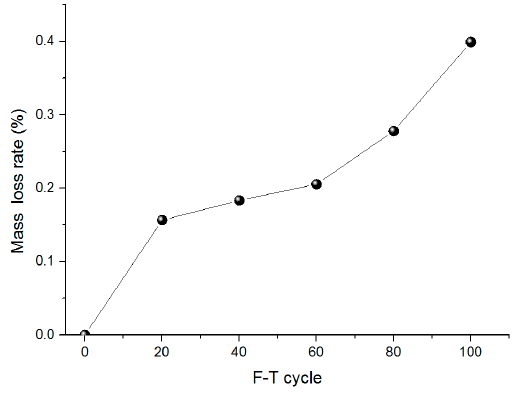
Figure 5. Plot of rock mass loss rate against freeze–thaw cycles.